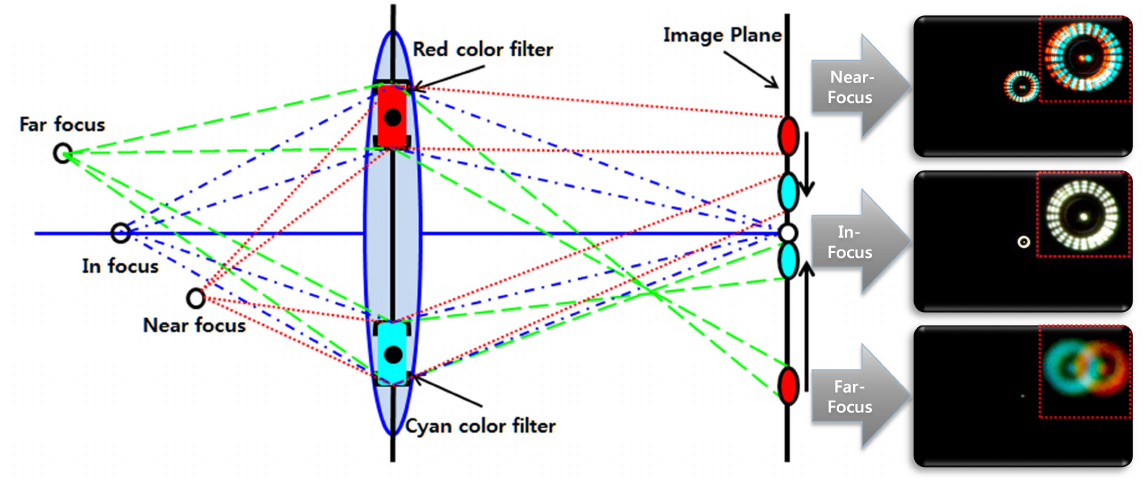
Figure 2. The convergence patterns of objects at three different distances in the DCA